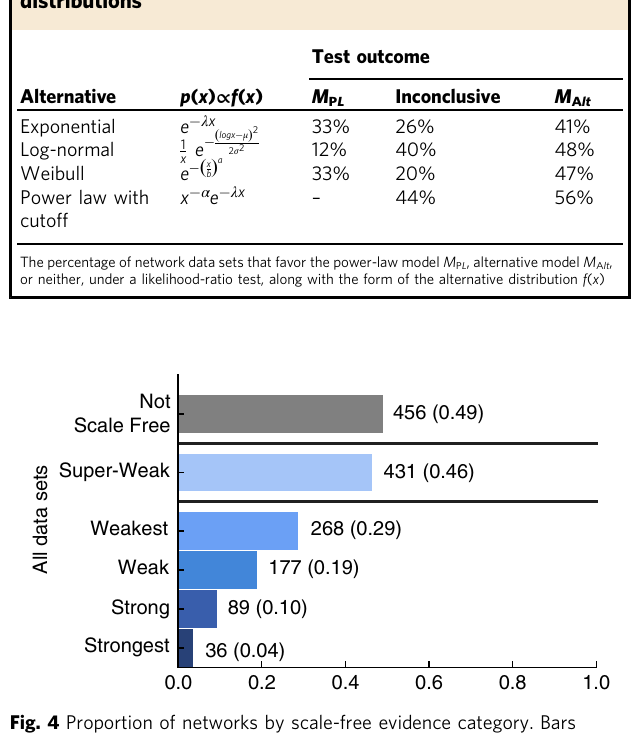
Table 1 Comparison of scale-free and alternative